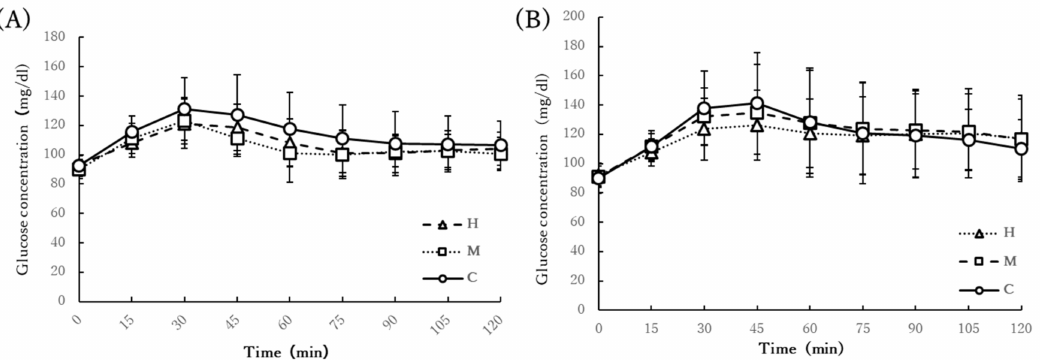
Figure 3. Changes in glucose concentration up to 2 h after ( A ) lunch and ( B ) dinner. The participants performed 11 min of home-based HIIE 30 min after a meal in the H condition (H), 30 min of moderate- intensity exercise 30 min after a meal in the M condition (M), and 30 min of seated rest 30 min after a meal in the C condition (C). There was no significant interaction between time and condition for changes in glucose concentration up to 2 h after lunch and